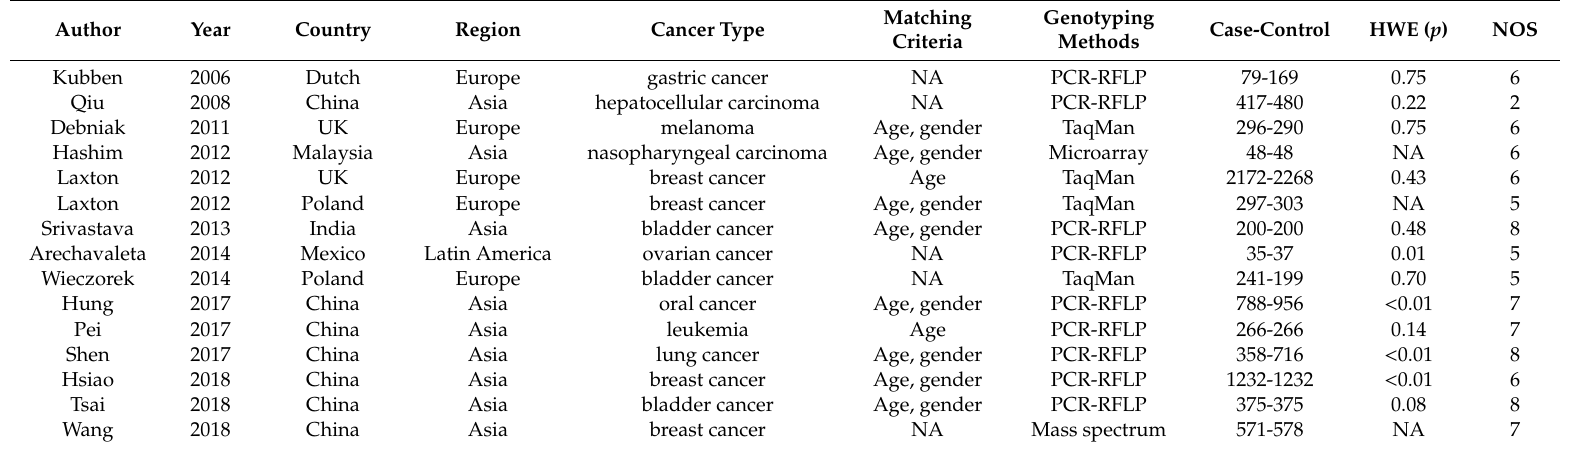
Table 1. Principal characteristics of studies included in this